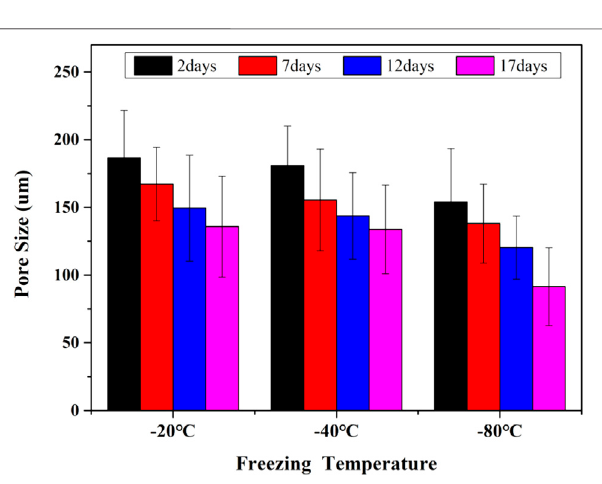
FIGURE 4 | The pore sizes of GelMA Hydrogels with different freezing temperatures and time.